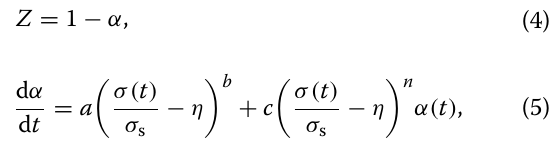
Table 1 Statistical parameters of random variables in China analysis method